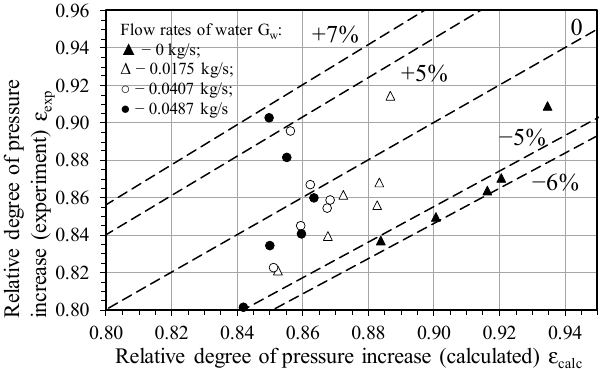
Figure 17. Comparison of the experimental data on the measurement of the relative pressure degree increase in the thermopressor ε exp with the calculated ε calc in accordance with the mathematical model at different flow rates of water, G w Relative degree of pressure increase (calculated) ε calc